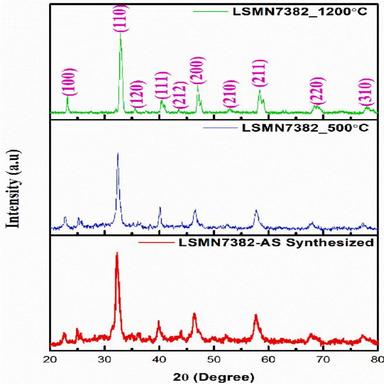
X-ray diffractograms of LSMN7382 powder: As-synthesized and calcined at 500 ◦C and 1200 ◦C for 2 h.